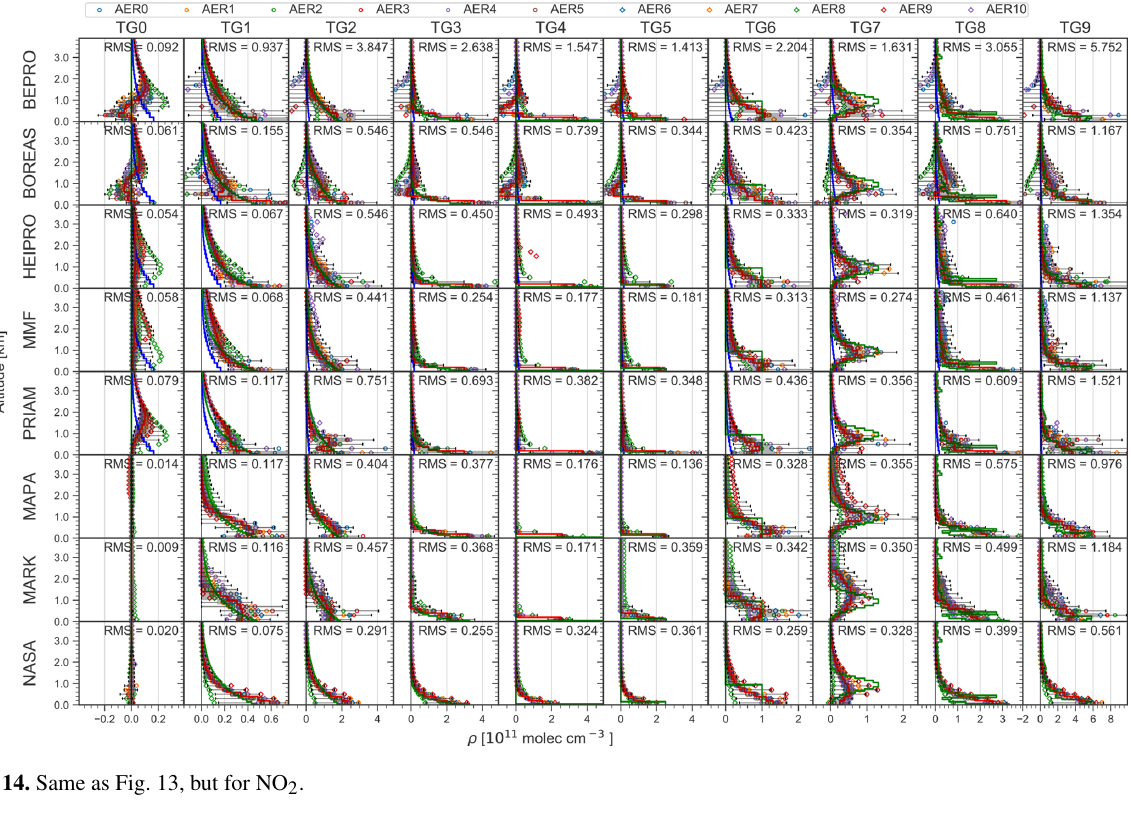
Figure 14. Same as Fig. 13, but for NO 2 .